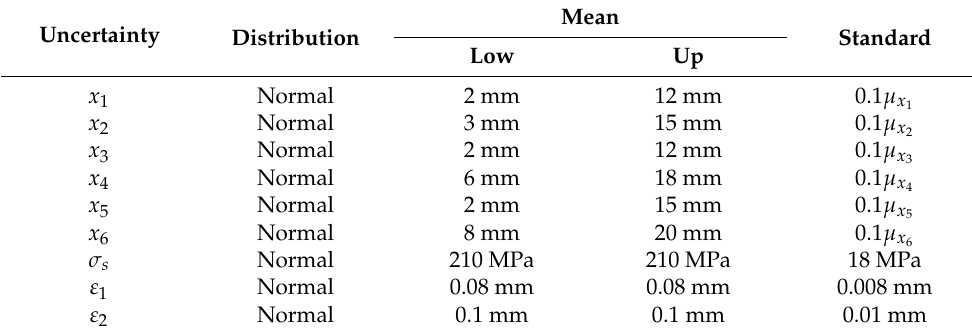
Table 2. Distribution of the uncertainties.